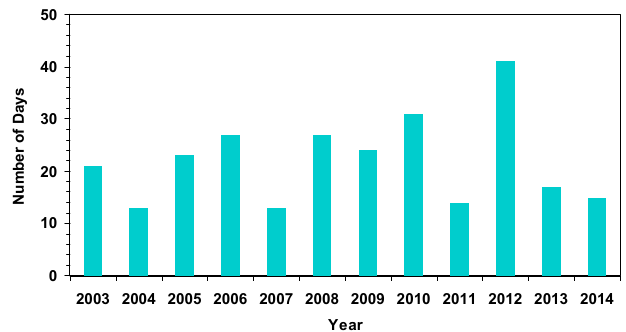
Figure 7. The time difference for the study period of available GRACE data between the dates for modeled peak snowmelt and observed peak river flow at the hydrometric station. The average is a 22 day offset.